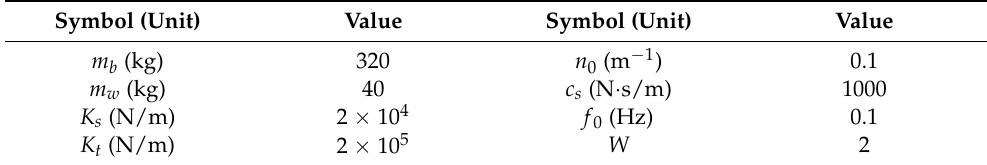
Table 2. The value of the vehicle model